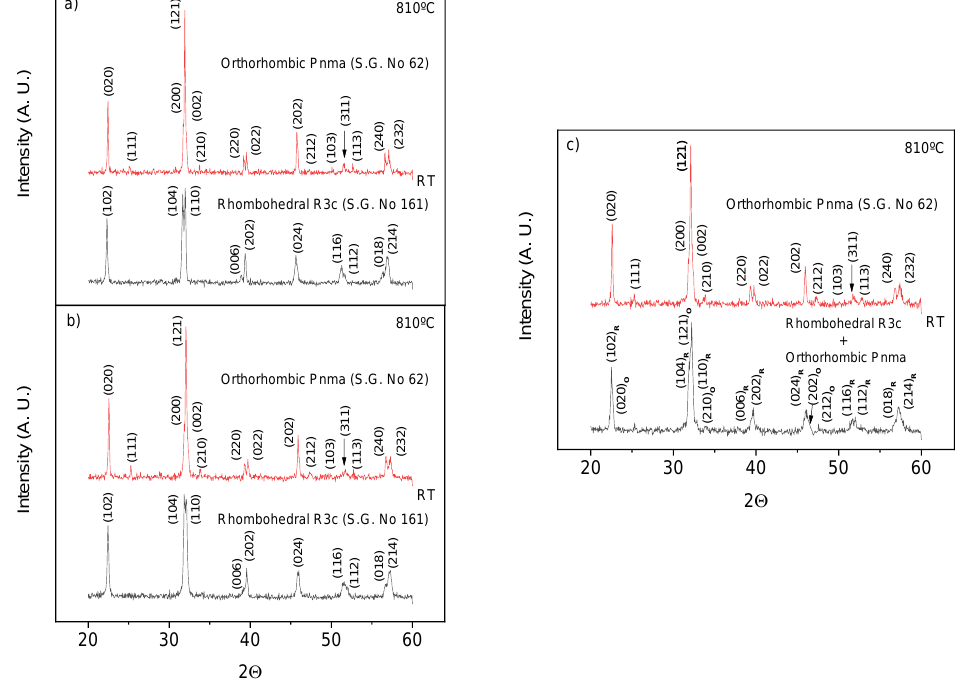
Figure 9. X-ray diffraction patterns at room temperature and 810 °C for (1 − x)YMnO 3 – xBiFeO 3 with ( a ) Figure 9. X-ray di ff raction patterns at room temperature and 810 ◦ C for (1 − x)YMnO 3 –xBiFeO 3 with x = 0.95, ( b ) x = 0.925, and ( c ) x = 0.9. ( a ) x = 0.95, ( b ) x = 0.925, and ( c ) x =